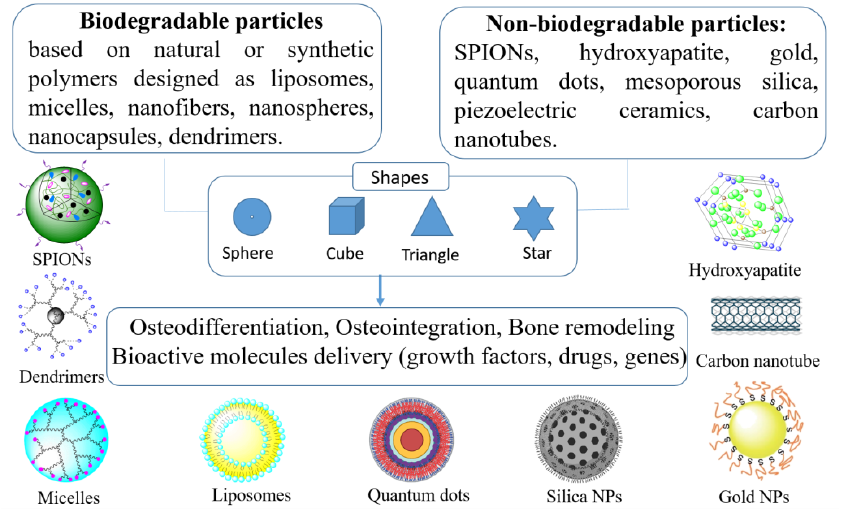
Figure 4. Types of nanomaterials used in bone tissue engineering.